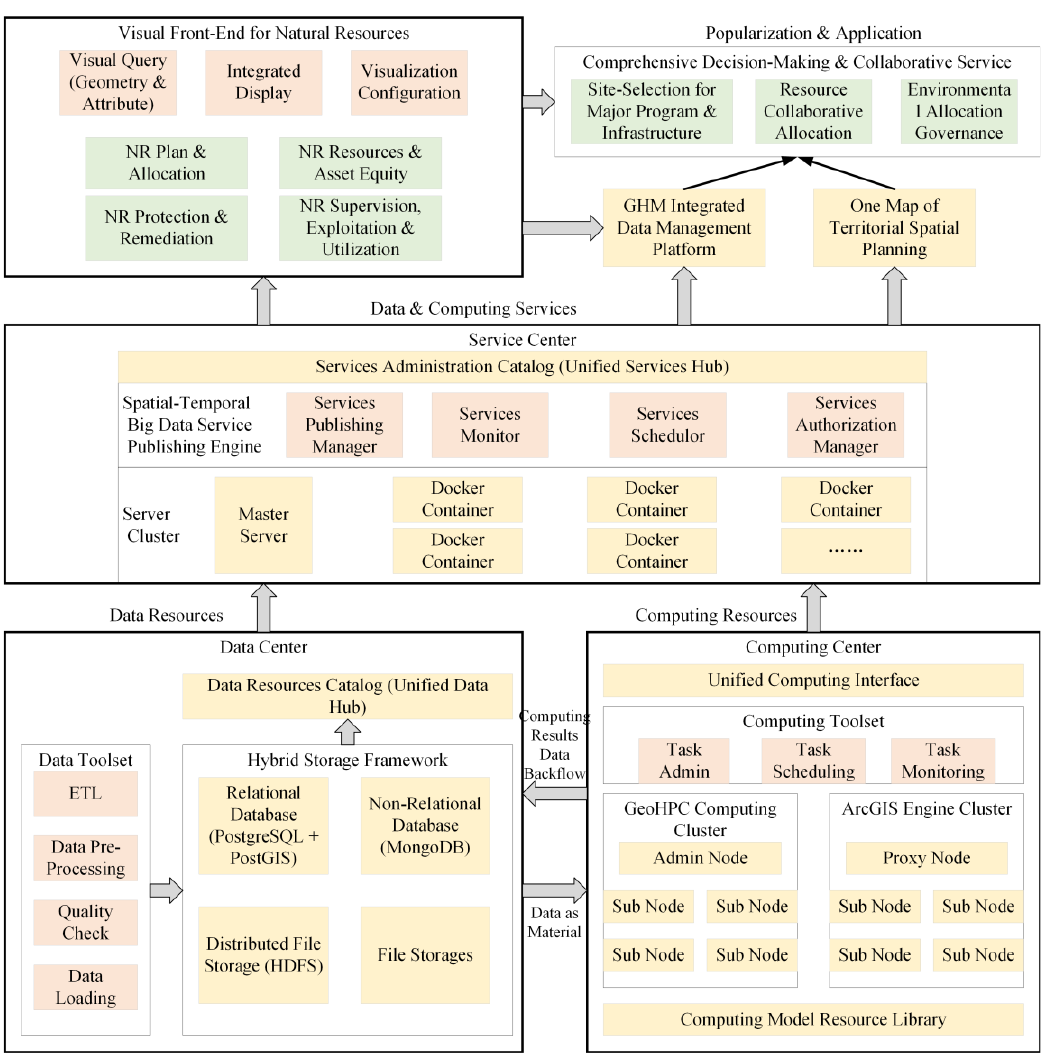
Figure 10. The macro-architecture of the NRIDB.